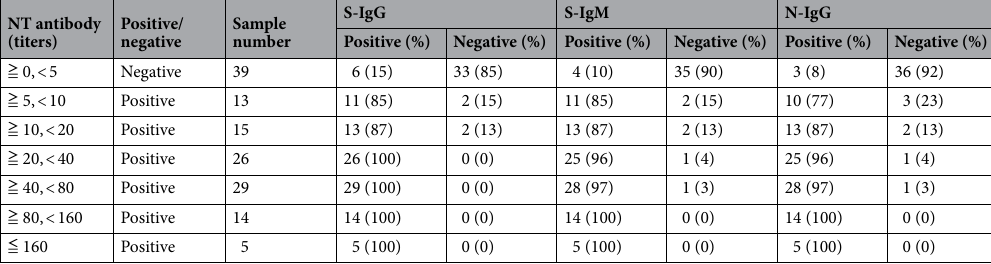
Table 1. Correlation between SARS-CoV-2 NT antibody activities and S-IgG, S-IgM, N-IgG antibody